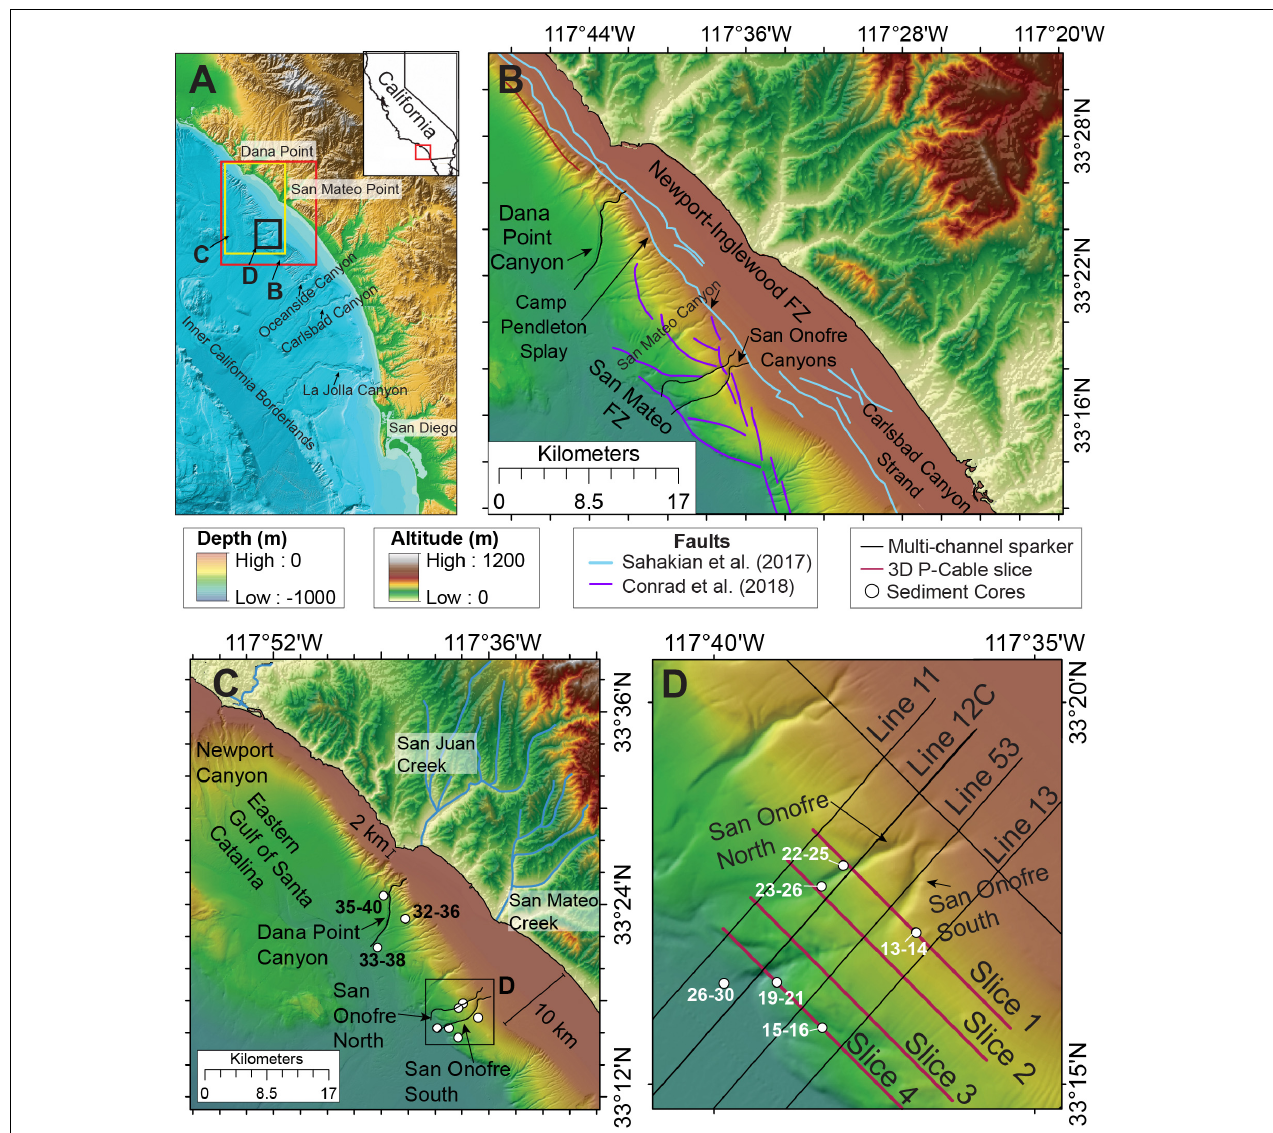
FIGURE 1 | (A) The Inner California Borderlands (ICB) is a tectonically active region located offshore of Southern California. This study focuses on the portion of the margin with the wide continental shelf. The locations of insets B, C, and D are shown. (B) Previously mapped active faults within the study area are shown. Blue faults are from Sahakian et al. (2017) and purple faults are from Conrad et al. (2018). FZ = Fault Zone. (C) Location of Dana Point and San Onofre North and South canyons. The area shown in inset D is outlined by the black box. (D) The study area offshore of San Onofre. This study uses 2D Sparker Multi-channel seismics shown by the black lines and slices of 3D P-cable Sparker seismics shown by the red lines. Gravity Cores (GC) and Jumbo Piston Cores (JPC) are labeled with white circles. Bathymetry from Dartnell et al.